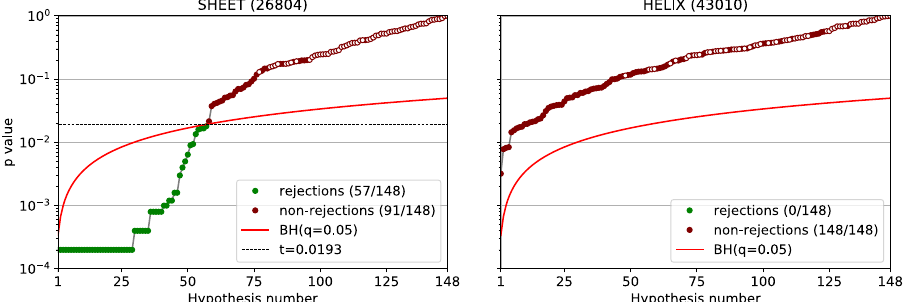
Fig. 4 p values obtained comparing pairs of synonymous codons in the β and α modes. The p values were obtained from the one-sided test detailed in the Methods. The total set of hypothesis tests included the 87 synonymous codon pairs with the addition of 61 comparisons of the codon with itself for control (denoted as empty circles). To correct for multiple tests, the rejection threshold corresponding to false discovery rate q = 0.05 was established using the Benjamini-Hochberg procedure (red curve). The set of tests on which the null was rejected is marked in green. For the identities of the rejected pairs, refer to Supplementary Fig.